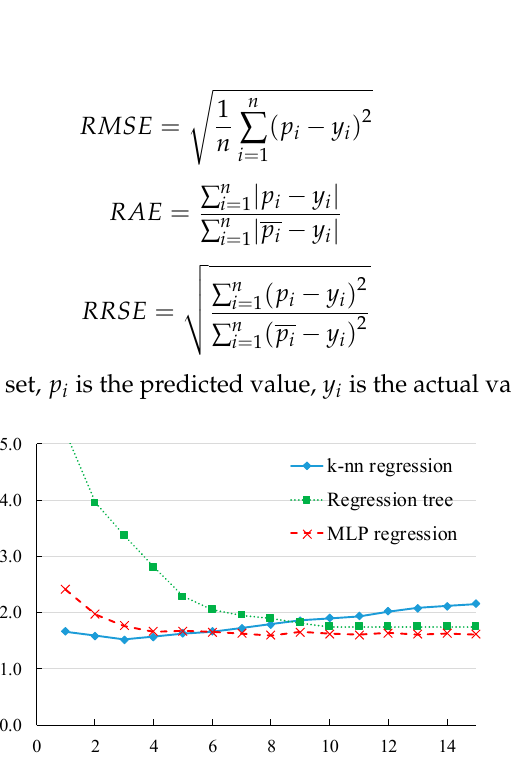
Table 3. Weights of the hidden layer ( ω 2